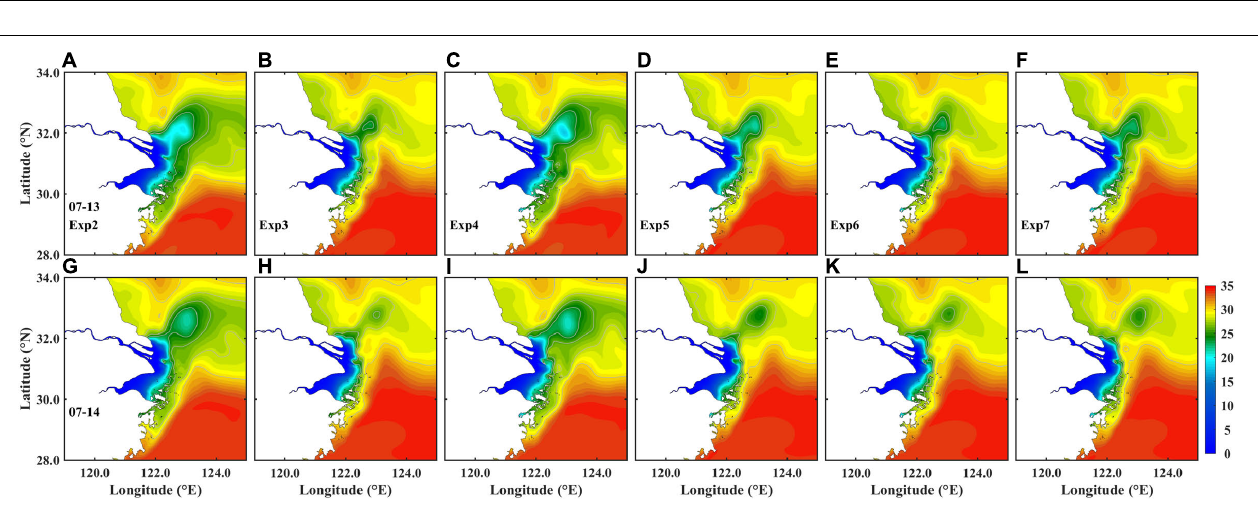
FIGURE 10 | The daily-averaged surface salinity (gray lines indicate 24, 26, 28, and 30 psu) on July 13 (upper panel) and 14 (lower panel) in (A,G) Exp2 (NoWave), (B,H) Exp3 (NoCWCBS), (C,I) Exp4 (NoFormDrag), (D,J) Exp5 (NoWDinTKE), (E,K) Exp6 (NoWRS), and (F,L) Exp7 (NoCARWE),